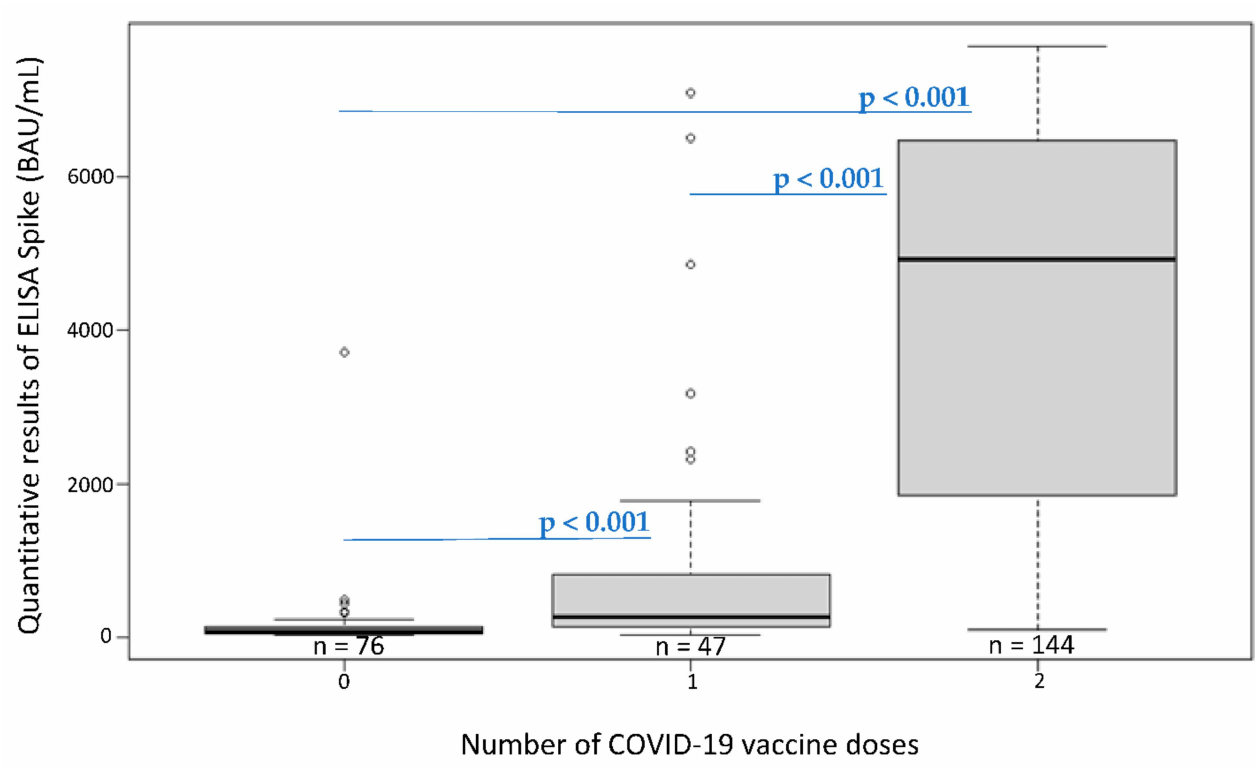
Figure 4. Levels of the IgG antibodies (BAU/mL) of participants with a quantitative ELISA-S result at the time of phase 3 according to their number of COVID-19 vaccine